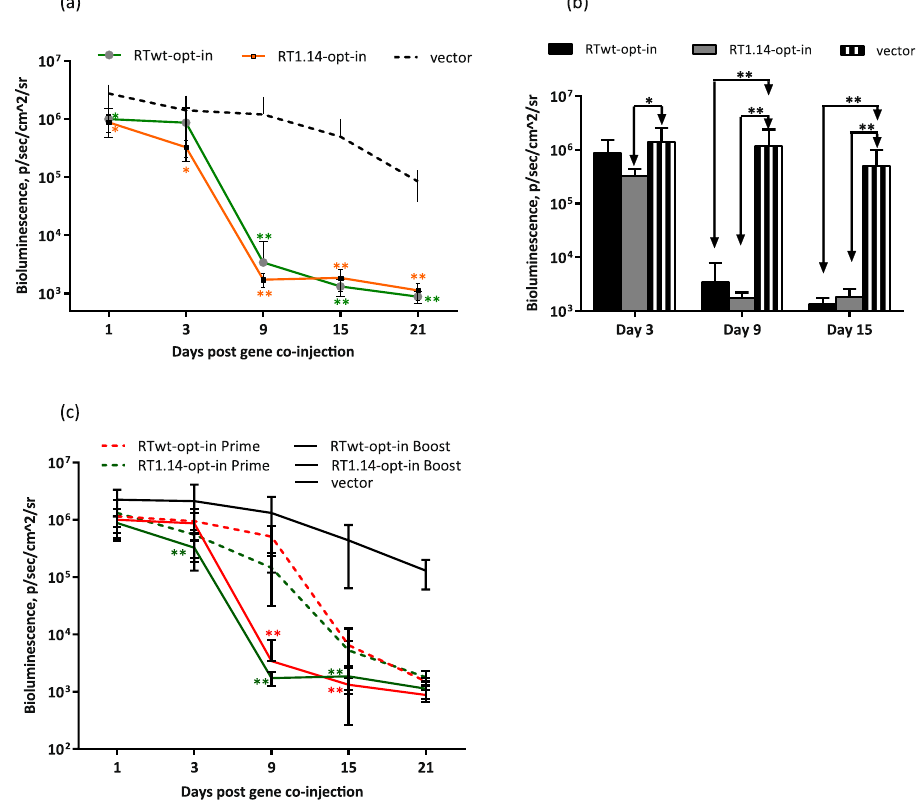
Figure 4. Effector immune response evaluated in vivo by “antigen challenge” in a prime-boost Luc/RT immunization of mice. BALB/c mice (n = 6) were immunized with two intradermal injections (29G needle) containing 40 µ g RTwt-opt-in or RT1.14-opt-in encoding plasmids per mouse with subsequent electroporation by Dermavax (standard protocol) and 4 weeks later boosted with 20 µ g of the same RT genes per mouse mixed 1:1 (w/w) with a Luc-encoding plasmid. Control mice received empty vector as a prime and a vector/Luc gene mixture as a boost. The emitted bioluminescence was monitored on days 1, 3, 9, 15, and 21 after boosting ( a , b ). Comparison of photon flux exhibited by mice primed with Luc/RT (Supplementary Fig. S4) or primed with RT and boosted with Luc/RT gene variants ( c ). Each curve ( a , c ) or bar ( b ) represents the average photon flux (photons/s/cm 2 /sr) from the injection area observed for the group of six mice (12 immunization sites), and the error bars represent the SD. The difference in photon flux between RT- and vector-immunized mice ( a , b ) and between prime and prime-boost groups of RT-immunized mice ( c ) is indicated by * p < 0.05 or ** p < 0.01. In ( a , c ) the asterisk color matches the curve color. Statistical comparisons were performed using Mann–Whitney